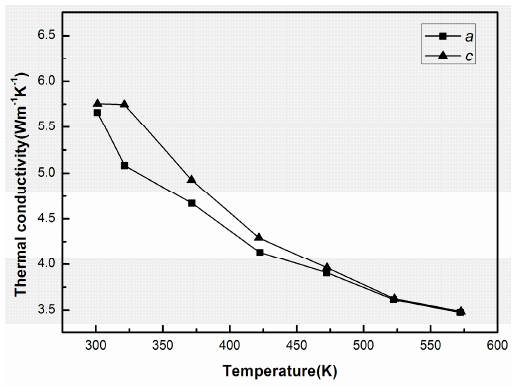
Figure 9. Thermal conductivity curves along the a -axis and c -axis of the Mg: 7 LiNbO 3 crystal.